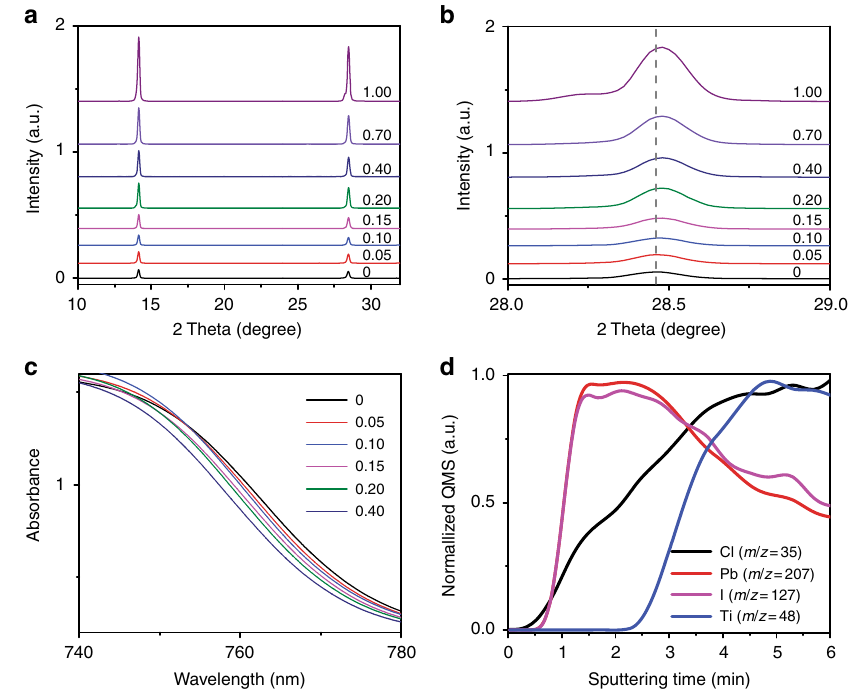
Fig. 2 Partial substitution of iodine ions by chorine ions. a , b X-ray diffraction (XRD) patterns of MAPbI 3 fi lms prepared with different molar ratios of MACl versus HPbI 3 in the HPbI 3 /MACl precursor solution. c UV − Vis spectra of MAPbI 3 fi lms prepared with different molar ratios of MACl versus HPbI 3 in the HPbI 3 /MACl precursor solution. d SIMS pro fi les showing I (magenta), Pb (red), Cl (black), and Ti (blue) elements from the top to the bottom of the MAPbI 3 fi lm prepared with the molar ratio of MACl versus HPbI 3 to be 0.10 in the HPbI 3 /MACl precursor